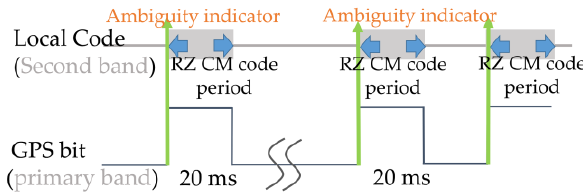
Figure 5. Bit-boundary assisted signal alignment.